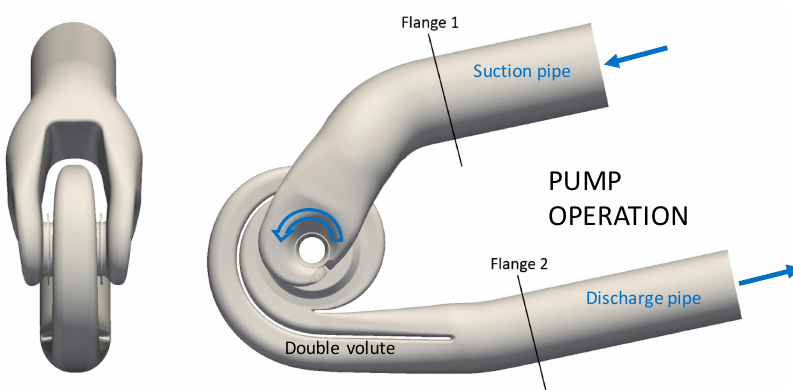
Figure 12. Front and side view of the CAD representing the centrifugal pump; the areas of Flange 1 and 2 were equal to 0.02840 m 2 and 0.01941 m 2 , respectively.